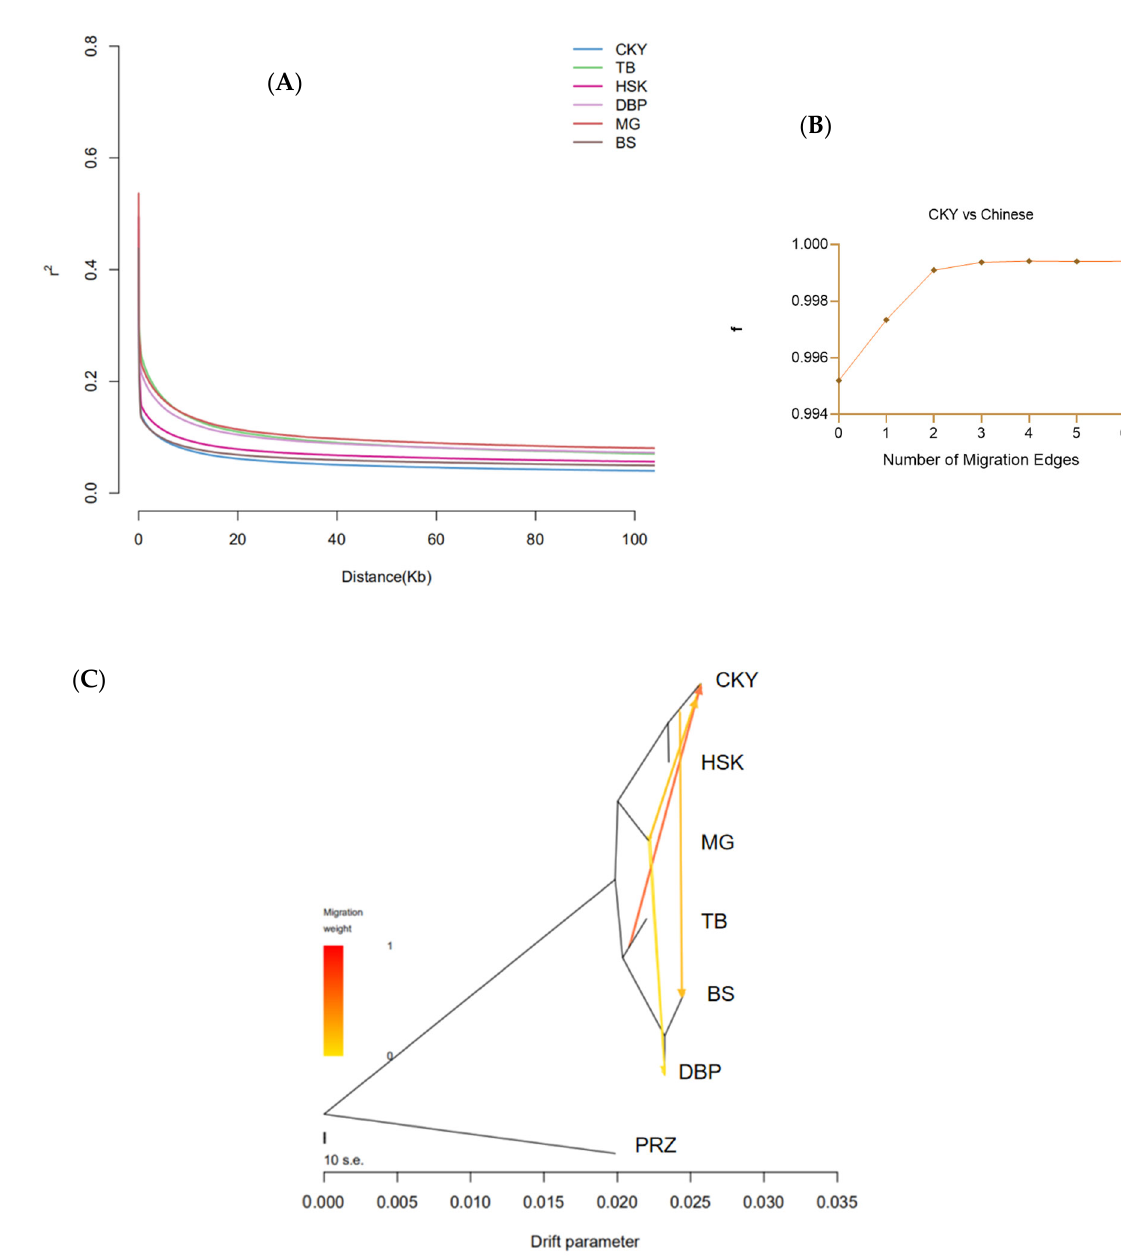
of the Chakouyi horse and other CHBs. Each column indicates an individual, and each column group represents a horse population. CKY, Chakouyi horse; HSK, Kazak horse; MG, Mongolian